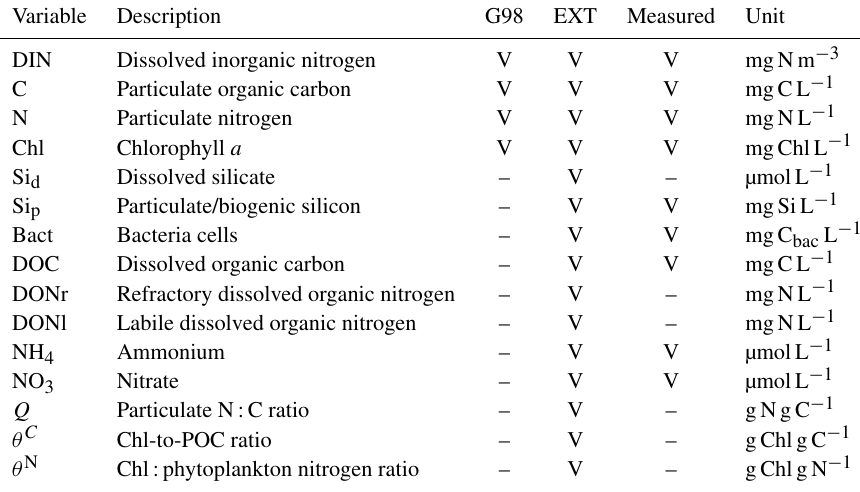
Table A1. State variables of the G98 model and the EXT model (marked with “V” if present and “–” if absent) with units and designation if these state variables had been measured in the